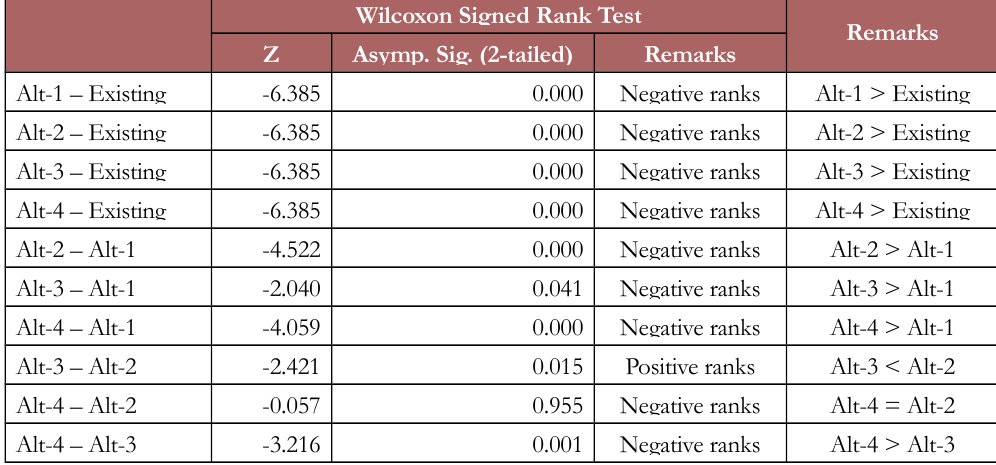
Table 7. Test of Normality